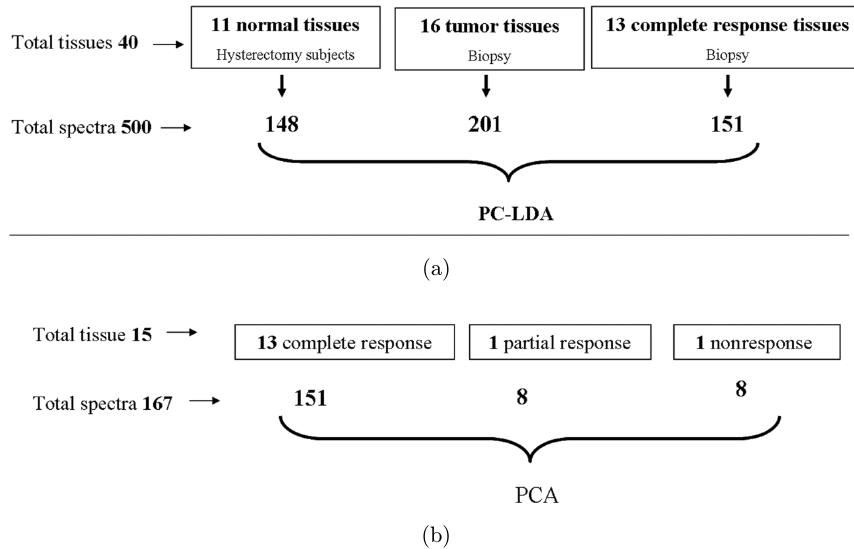
Fig. 1. Schematic representation of methodology: (a) total number of tissues and spectra used in PC-LDA, (b) total number of tissues and spectra used in